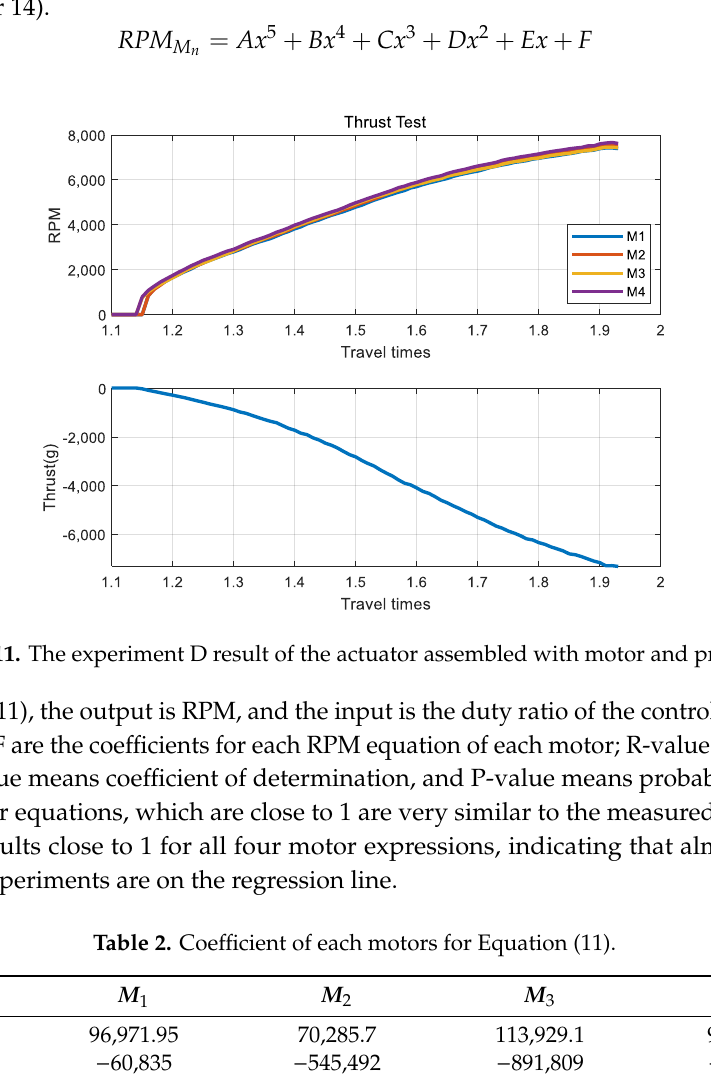
Table 2. Coefficient of each motors for Equation (11).